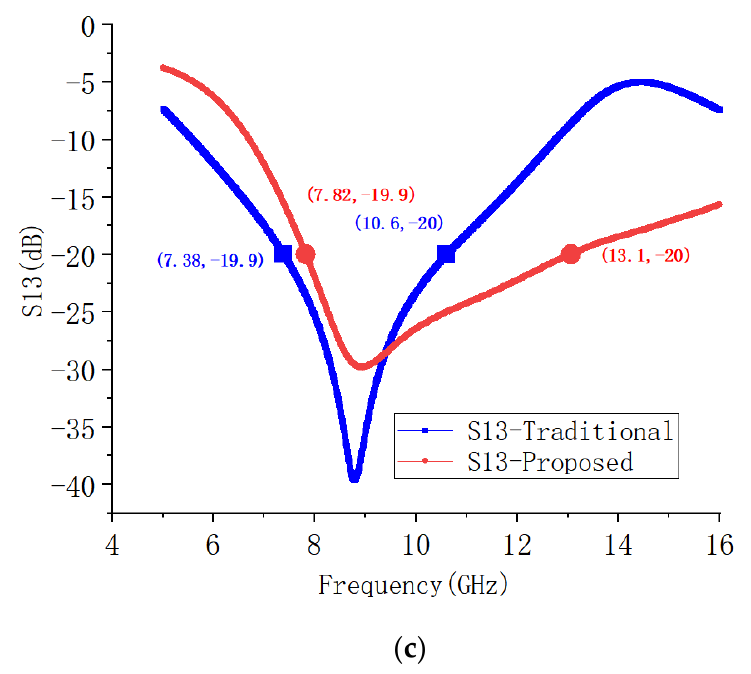
Figure 12. The results of the measurement for the S parameters of the traditional bias circuit and the proposed bias circuit. ( a ) S12. ( b ) S11. ( c ) S13.